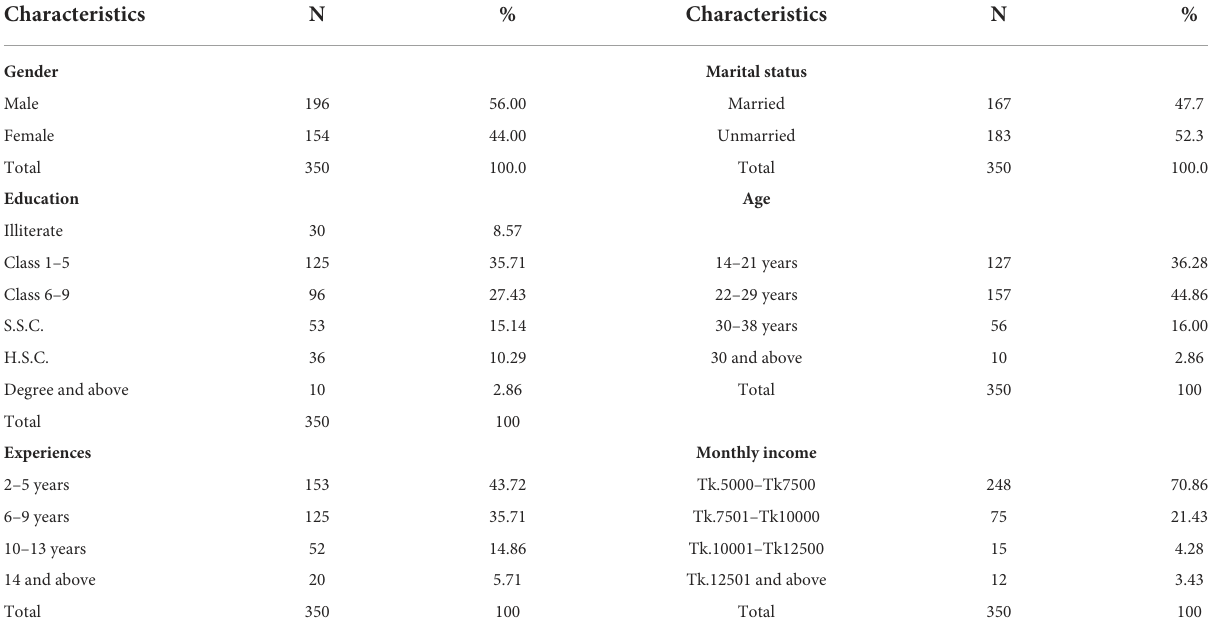
TABLE 5 Socio-demographic profile of the